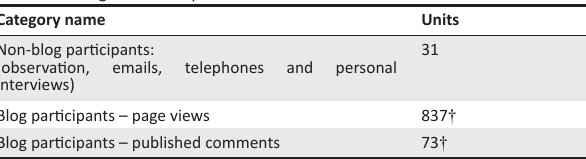
TABLE 3 : Categories of